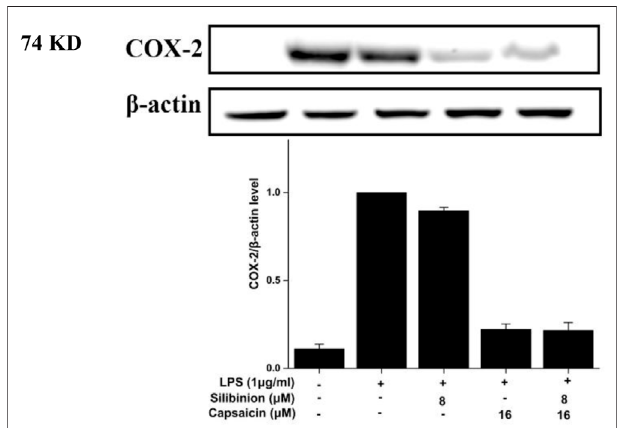
FIGURE 5 | Effect of silibinin and capsaicin on the LPS-induced COX-2. After separated by SDSPAGE (8%), transfer to the nitrocellulose membrane, and block for 1 h in non-fat milk (5%), the sample was incubated with the primary antibodies COX-2 overnight at 4 ° C, and subsequently incubation with the secondary antibody for 1 h.